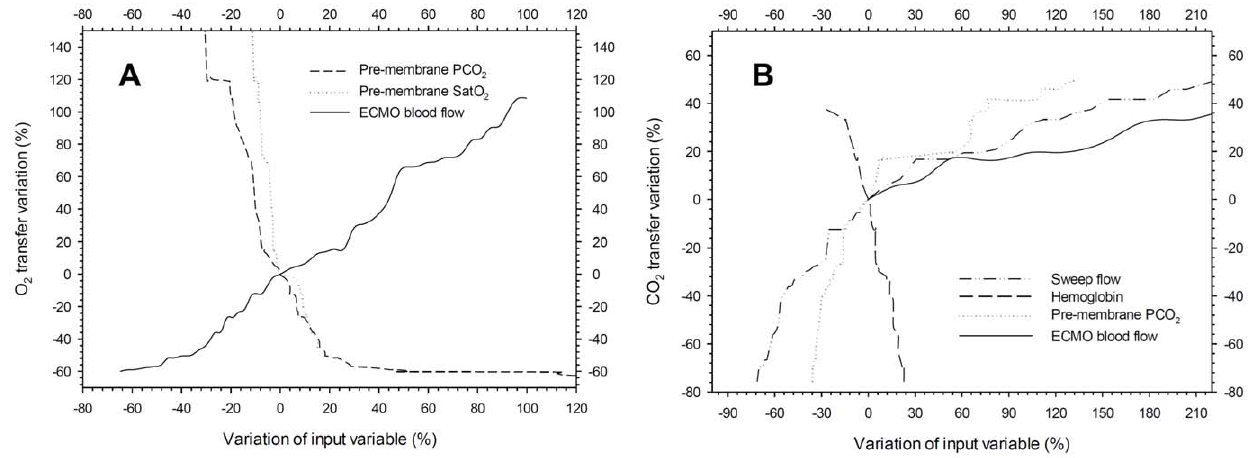
Figure 2. Spider plots showing the strength of association between O 2 transfer (Panel A) and the variables extracted from the multivariate analysis and the association between CO 2 transfer (Panel B) and the variables extracted from the multivariate analysis. All data were collected from the animals, with and without multiple organ failure. The input variables are shown in the legend.